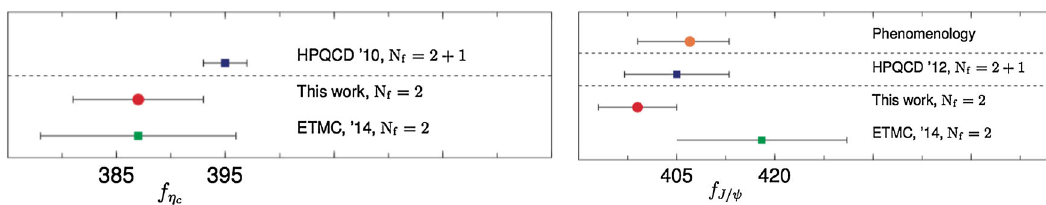
(left panel) and f J /ψ (right panel) c